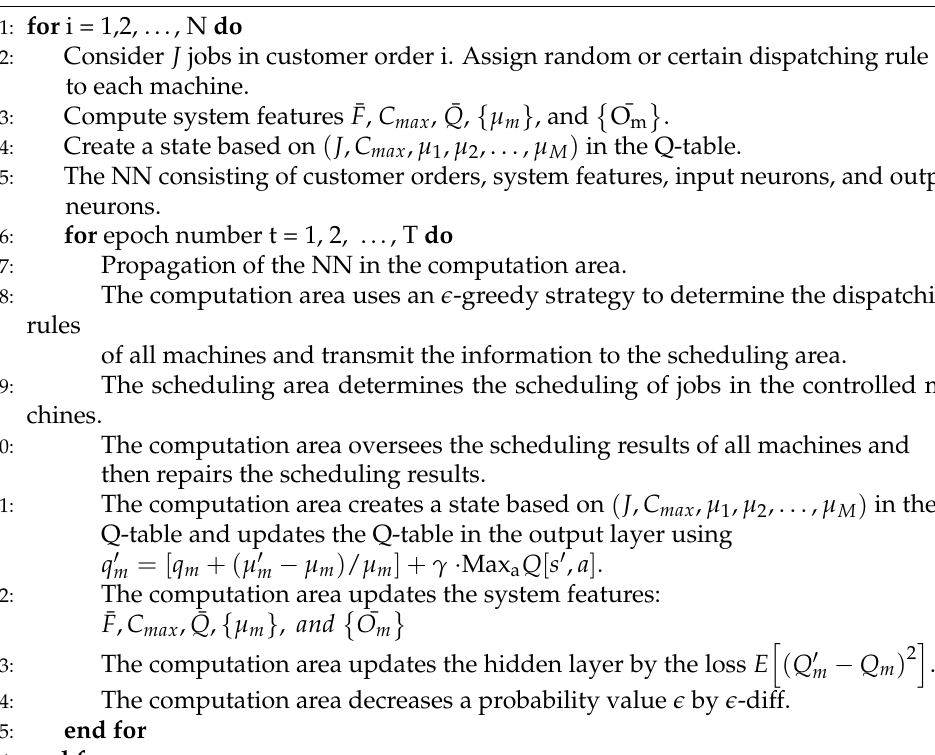
Algorithm 1 The DQN performed only in the MEC (N customer